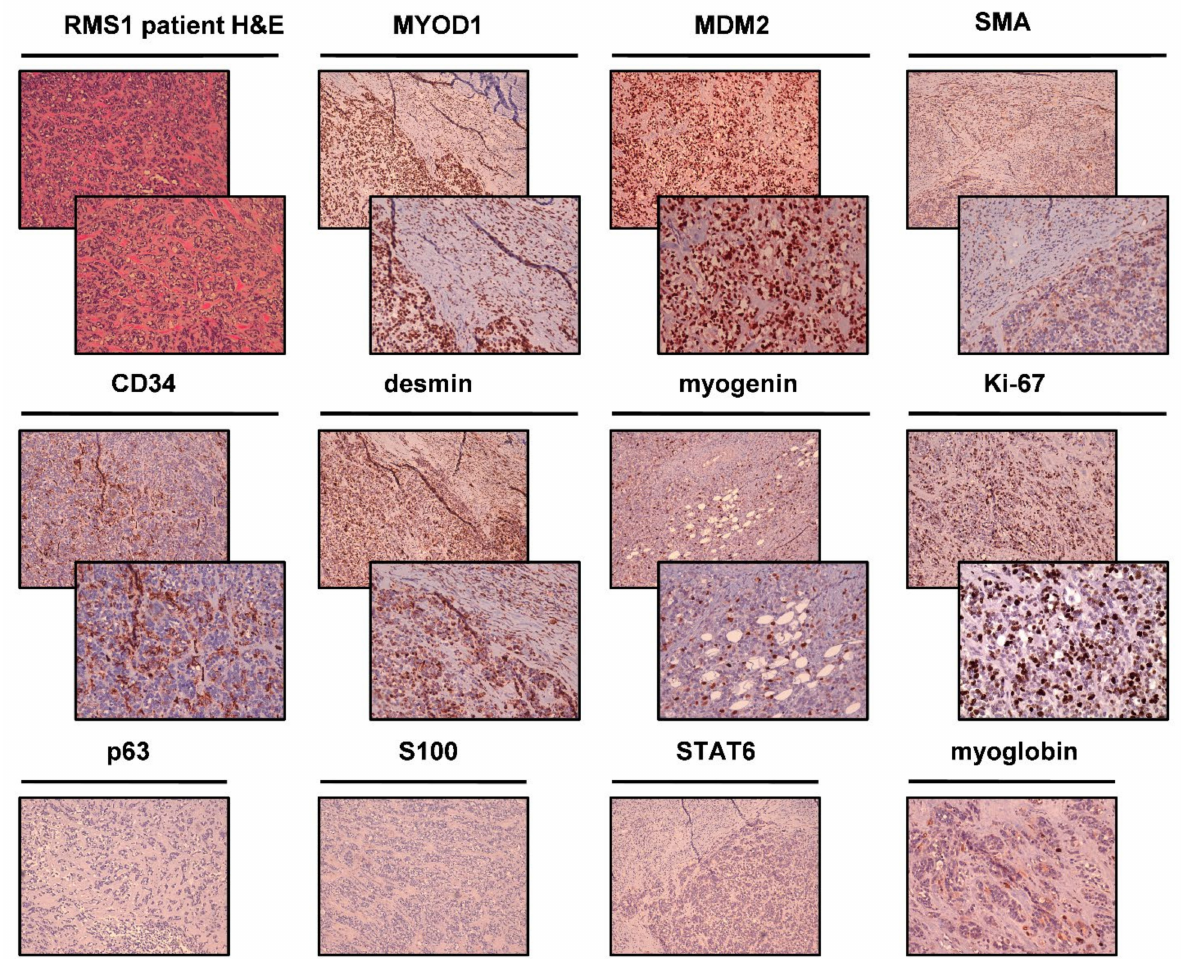
Figure 2. RMS1 patient histological and immunohistochemical analyses. H&E of the patient surgically resected tumor specimen. IHC analysis was performed on the patient surgically resected tumor specimen for the following markers: MYOD-1, MDM2, SMA, CD34, desmin, myogenin, Ki-67, p63, S100, STAT6, and myoglobin. For each marker, upper panels represent 10 × magnification, and lower panels represent magnification 20 × (negative markers are represented with only 10 ×